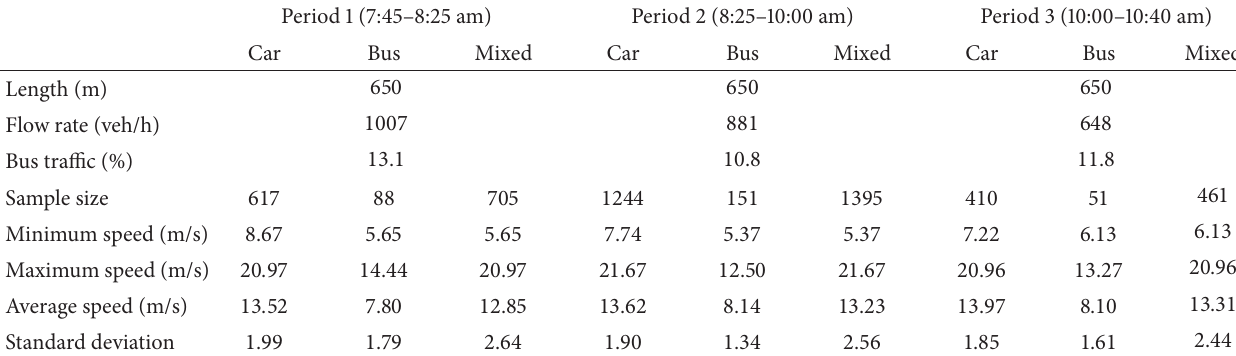
Table 1: Origin platoon journey speed data.